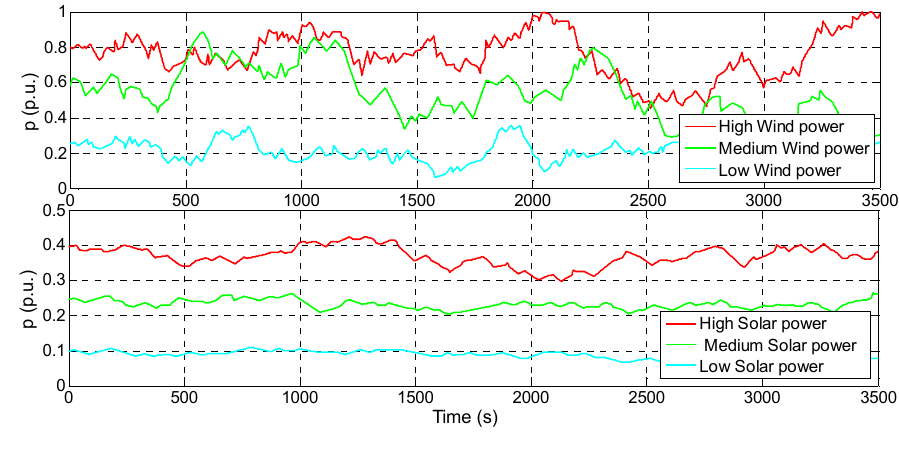
Figure 7. Wind and solar power records taken from [31]. Table 4. Wind and solar power scenarios analyzed in the paper. H = high, M = medium, L = low.